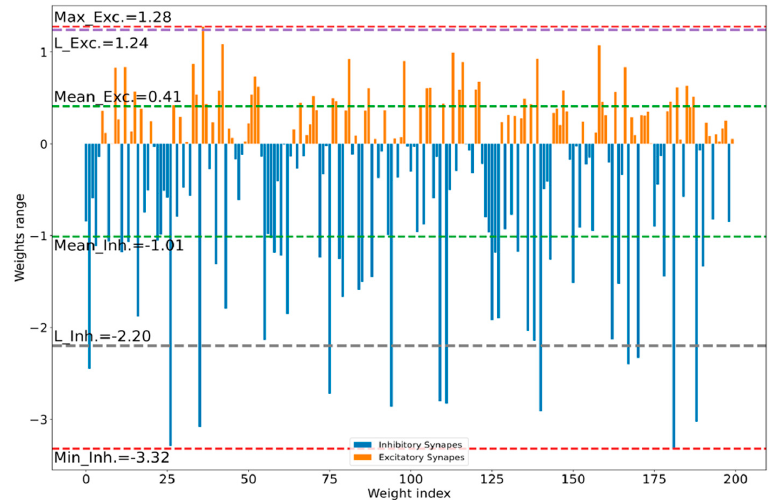
Figure 7. SNN output layer 32-bit floating-point weights (Excitatory weights = 46.5% and Inhibitory weights = 53.5%).